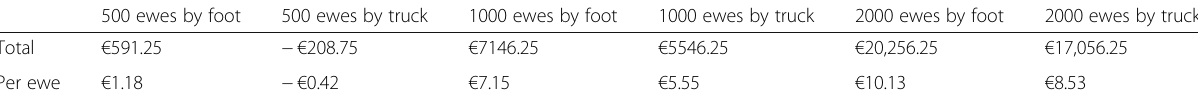
Table 5 Comparison of relative profitability of transhumant compared to semi-extensive operations based on “ Most likely ” parameter estimates